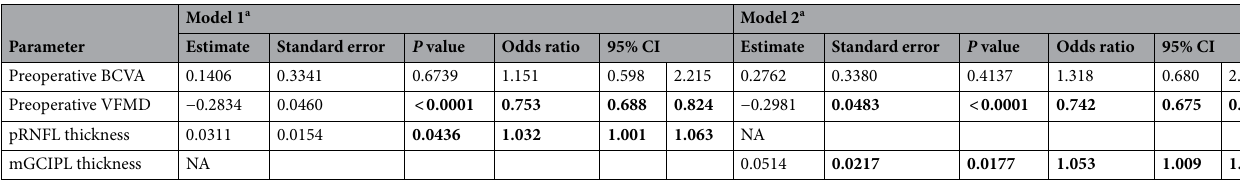
Table 3. Multivariable logistic regression analysis of significant recovery. Significant values are indicated in bold. BCVA best-corrected visual acuity, CI confidence interval, SER spherical equivalent refractive